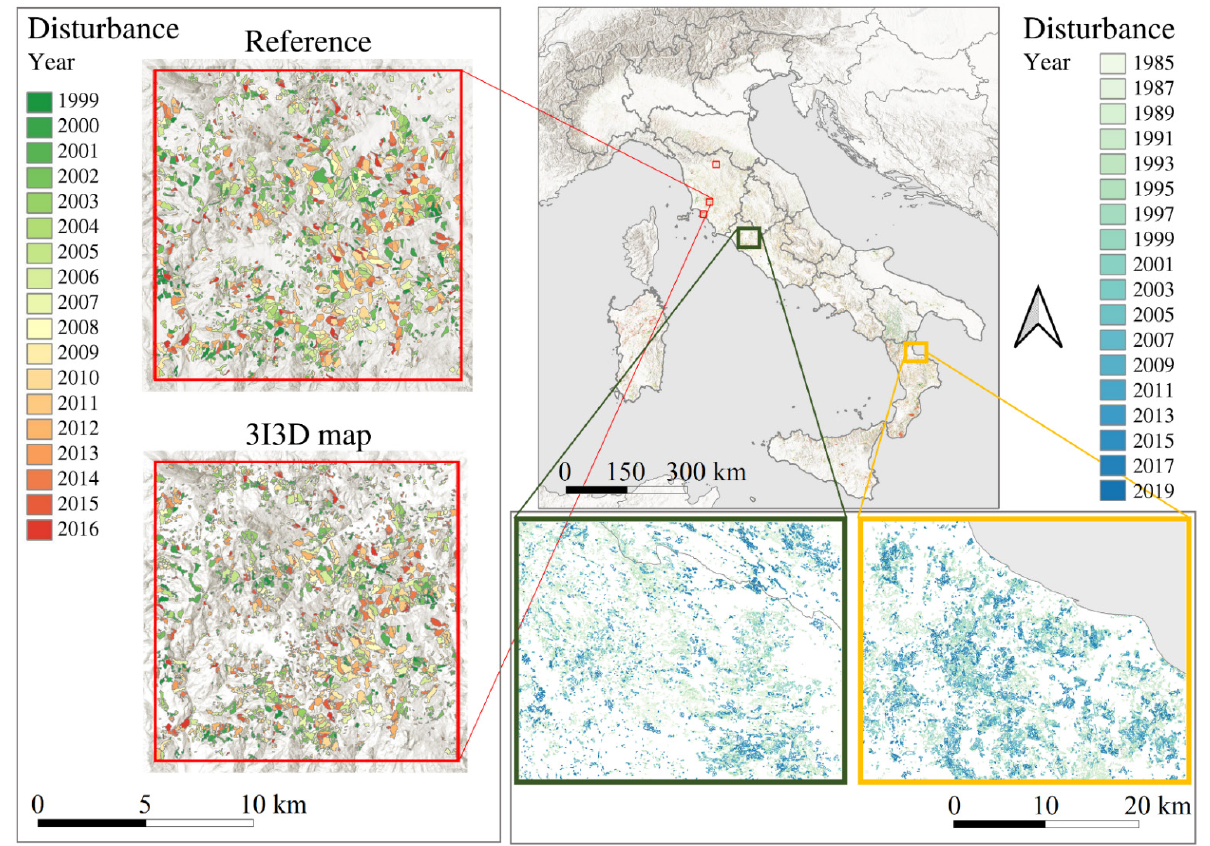
Figure 4. Comparison between predicted forest disturbance and clearcuts in one of three cells (in red) of the reference dataset (left). Predicted forest disturbance map (top-right) and two focuses (bottom-right).